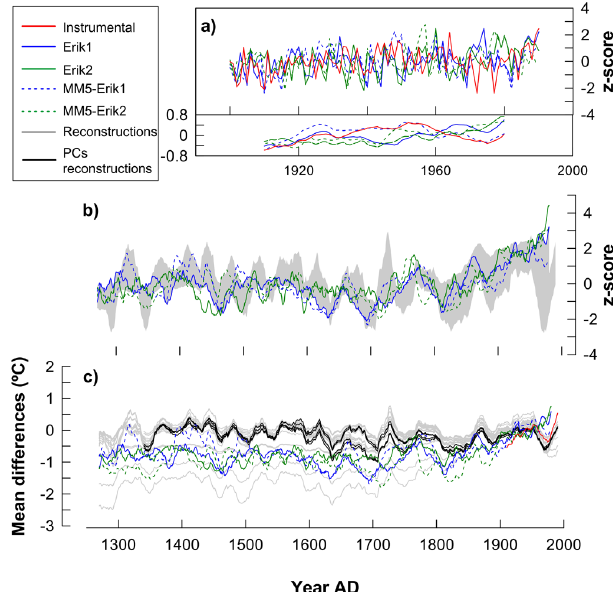
Fig. 7. Comparison of reconstructed and simulated May-to- September mean temperature ( T MJJAS ) for the last 750yr. Grey lines/shade correspond to the range of the 24 MXD-based tem- perature reconstructions developed at the Pyrenees. Coloured lines correspond to the different model outputs: Erik1 (blue), Erik2 (green), MM5-Erik1 (dashed blue) and MM5-Erik2 (dashed green). (a) Comparison of the simulated and the instrumental T MJJAS record (red line). (b) Series scaled to mean 0 and standard de- viation 1. (c) Series in anomalies (differences from reference pe- riod 1900–2005AD). Black series correspond to the reconstructions PCs RCS S, PCs RCSPT S, PCs 300sp S and PCs 300spPT S. All series smoothed with a 20yr centred moving average (except for the upper half of panel a